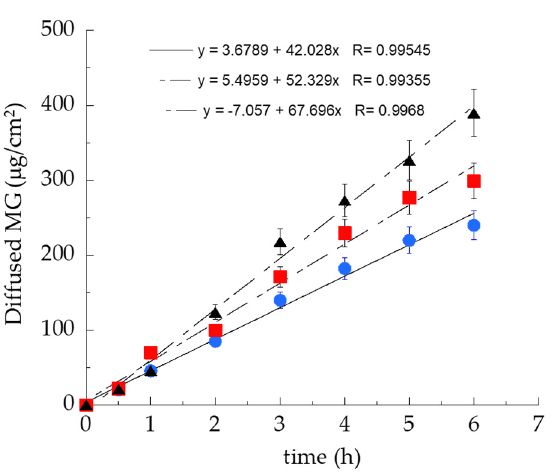
Figure 4. Effect of membranes ( a ) and receiving phases ( b ) on MG diffusion kinetics. Experiments were performed using Figure 5. MG diffusion kinetics from Sol-MG ( ), E-MG ( ), or TE5-MG ( ), as determined by the Figure 5. MG diffusion kinetics from Sol-MG ( ), E-MG ( ), or TE5-MG ( ), as determined by the Franz cells. ( a ) nylon ( ), MCE ( × ), PTFE ( o ) membranes and ethanol/water 50:50, v/v as receiving phase; ( b ) ethanol/wa- Figure 5. MG diffusion kinetics from Sol-MG ( ), E-MG ( ), or TE5-MG ( ), as determined Franz cells assembled with the nylon membrane and ethanol/water 50:50 v/v as receiving phase. Figure 5. MG diffusion kinetics from Sol-MG ( ), E-MG ( ), or TE5-MG ( ), as determined Figure 5. MG diffusion kinetics from Sol-MG ( ), E-MG ( ), or TE5-MG ( ), as determined Figure 5. MG diffusion kinetics from Sol-MG ( ), E-MG ( ), or TE5-MG ( Franz cells assembled with the nylon membrane and ethanol/water 50:50 v/v as receiving phase. Data are the mean of 6 independent experiments ± s.d. by the Franz cells assembled with the nylon membrane and ethanol/water 50:50 v/v as receiving by the Franz cells assembled with the nylon membrane and ethanol/water 50:50 v/v as receiving ter 50:50, v/v ( ), ethanol/water 30:70, v/v ( □ ), water ( ◊ ) as receiving phases and nylon as membrane. Data are the mean by the Franz cells assembled with the nylon membrane and ethanol/water 50:50 v/v as receiving Figure 5. MG diffusion kinetics from Sol-MG ( ), E-MG ( ), or TE5-MG ( ), as determined Data are the mean of 6 independent experiments ± s.d. phase. Data are the mean of 6 independent experiments ± phase. Data are the mean of 6 independent experiments ± s.d. of 6 independent experiments ± s.d. phase. Data are the mean of 6 independent experiments ± s.d. by the Franz cells assembled with the nylon membrane and ethanol/water 50:50 v/v as receiving phase. Data are the mean of 6 independent experiments ± s.d.